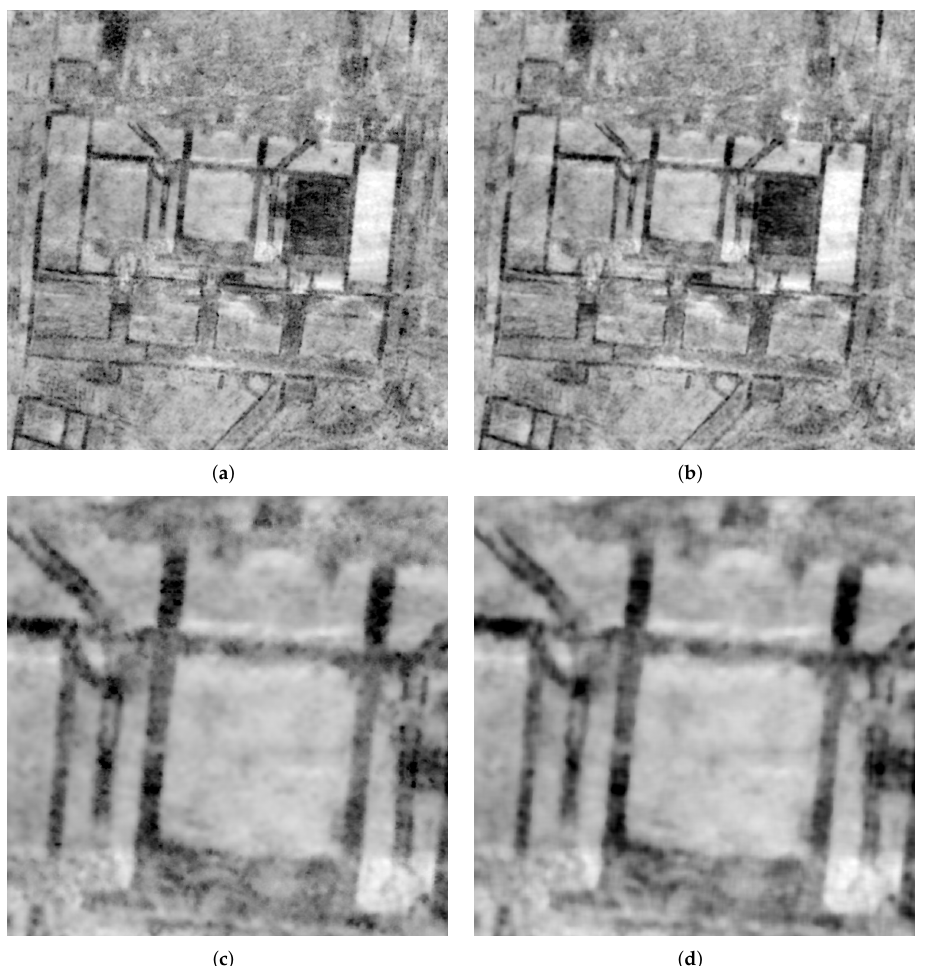
Figure 5. Results of a 3D bilateral filter ( a , c ) and a median filter ( b , d ) applied to a GPR dataset. Both filters reveal the actual boundaries of the foundation walls in a more defined way compared to the original image in Figure 1. The bilateral filter avoids blurring at structure